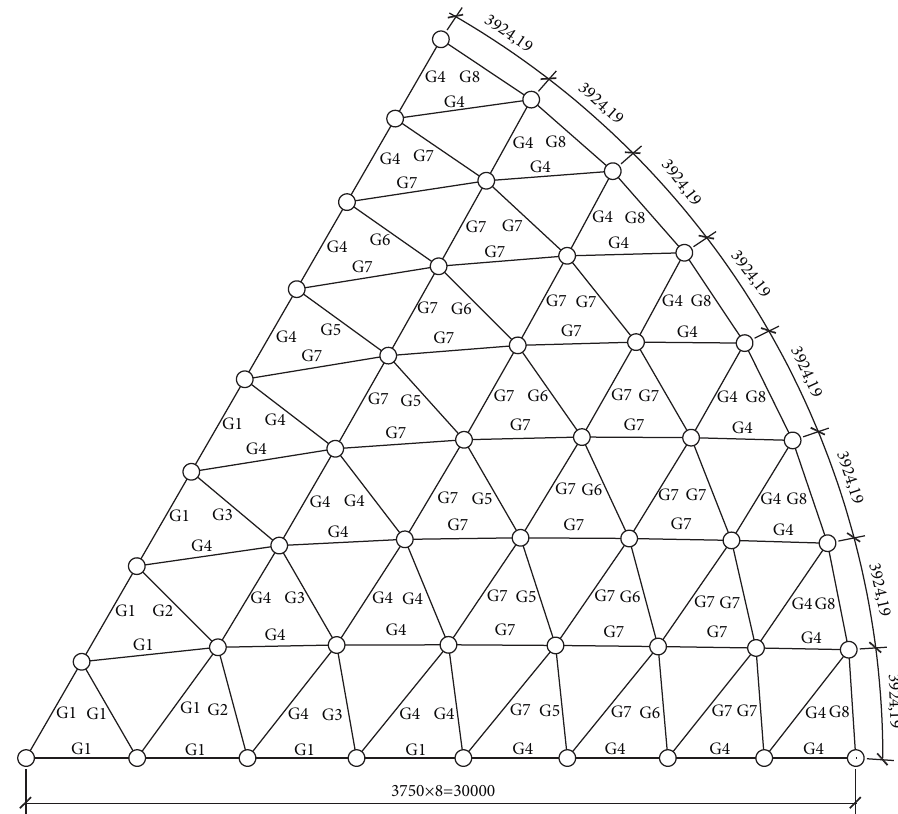
Figure 5: Te layout of the shell